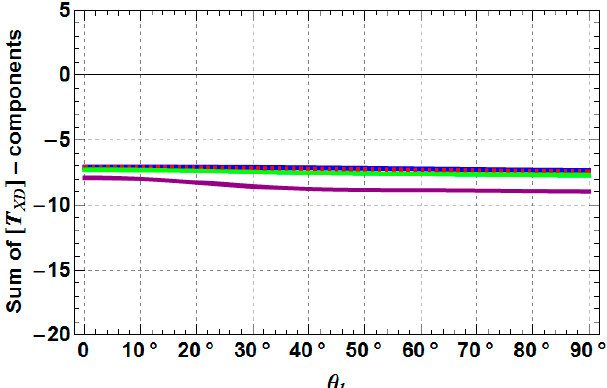
Figure 23. Sensitivity of T XD22 + T XD33 along roughness angle θ 1 ( ε s = 20, ε t = 10, ω l = 30°, L SXD = 1) with